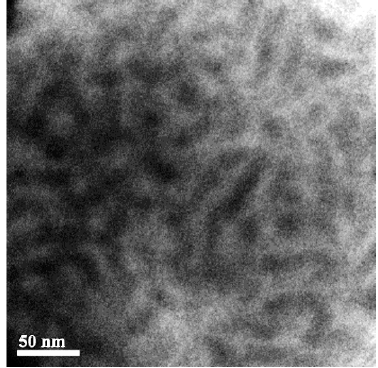
Figure 6. TEM image of S-SEBS block copolymer.